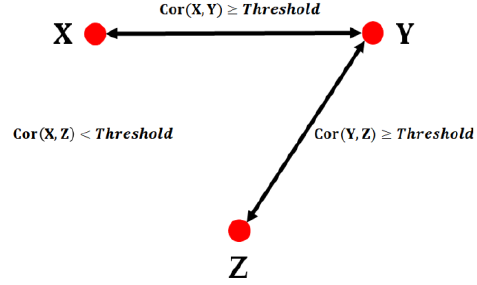
Figure 4. Correlation network structure.